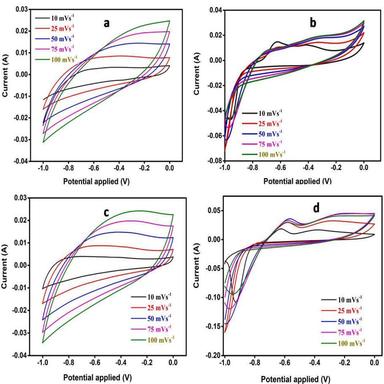
Cyclic voltammetry analysis of (a) Lu 0, (b)Lu 0.3, (c) Lu 0.5, and (d) Lu 0.7 at different scan rates from 10 to 100 mVs− 1 with 3 M K.O.H. electrolyte.